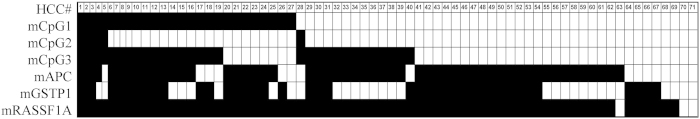
Comparison of HBV and host gene methylation in HBV-HCC. Each column represents one sample of the 71 HBV-HCC. Each row depicts the overall methylation status of either the viral CpG islands (mCpG1/2/3) or host gene promoter regions (mAPC/mGSTP1/mRASSF1A). Filled rectangles indicate methylation detected and open rectangles indicate methylation below the level of detection.